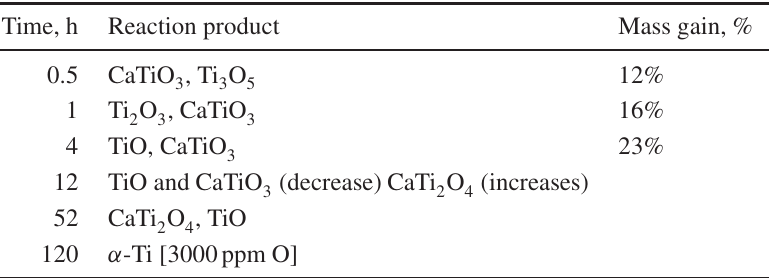
[14]. Cell voltage: 2.5V for 0–8 h, 2